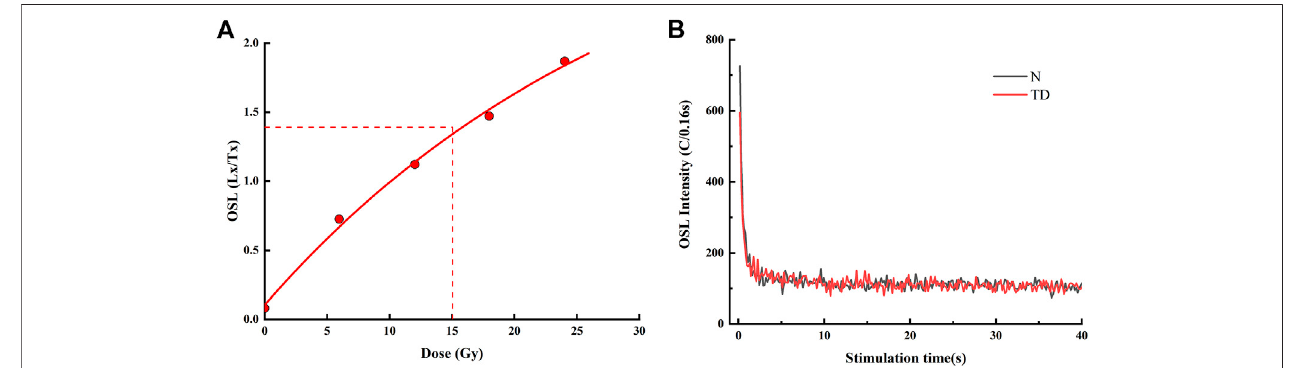
FIGURE 6 | OSL regenerative-dose growth curves (A) and decay curves (B) for samples DT14.